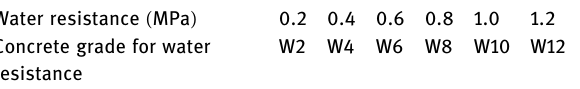
Table 7: Water resistance of the concrete specimens Water resistance ( MPa )